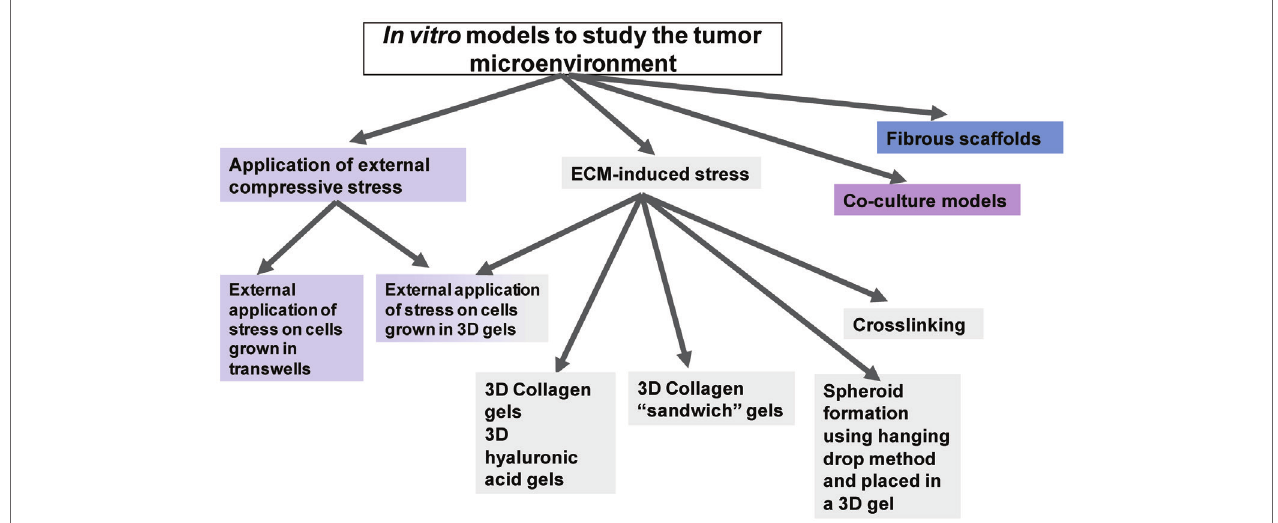
FiGURe 2 | Diagrammatic representation of the available in vitro models to study tumor microenvironment